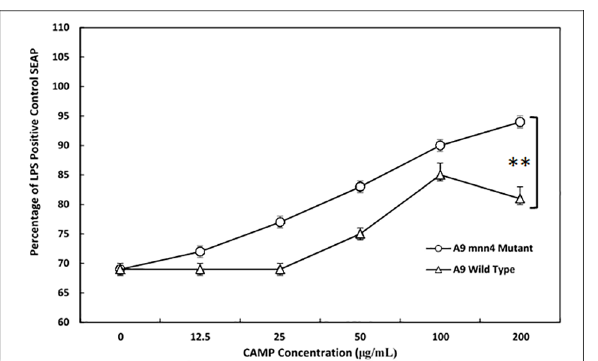
Fig 11. CMPs derived from C . albicans A9 and A9 mnn 4 Δ mutant strains both stimulate HEK-TLR4 cells. The A9 mnn 4 Δ mutant CMP lacks phosphodiester-linked extensionson the N -linkedglycans and was found to be superiorto CMP from the A9 parent strain as a TLR4 agonist. In this experimentSEAP conversion was stoppedat 45 min. Peak LPS stimulationcorresponded to mean absorbance of 0.11 +/- 0.004 absorbance units (positive control). The negative control wells received only additionalmedia. All data were convertedto percentage of LPS control by dividingthe mean net absorbance of CMP treated cells by the mean net absorbance of LPS treated cells. SEM was convertedto % SEM in the same manner. Significance that is representedby the asterisks was p (cid:20)